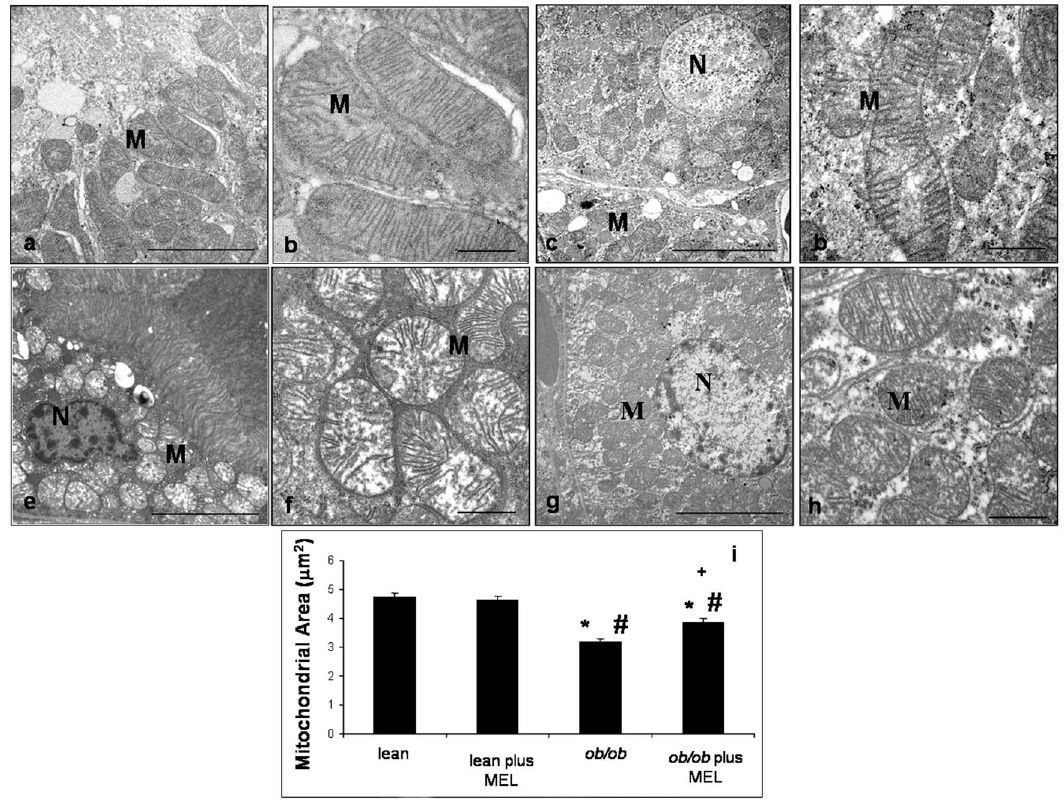
Figure 2. Transmission electron microscopy. Ultrastructural photomicrographs showing cortical proximal tubules and mitochondria of lean (a, b), lean mice treated with melatonin (c, d), ob/ob (e, f) and ob/ob treated with melatonin mice (g, h). The graph summarizes the quantitative analyses of mitochondrial area of each experimental groups (i). (M) mitochondria and (N) nucleus. Bar equals 1 m m. * p , 0.05 vs lean, # p , 0.05 vs lean plus melatonin and + vs ob/ob .